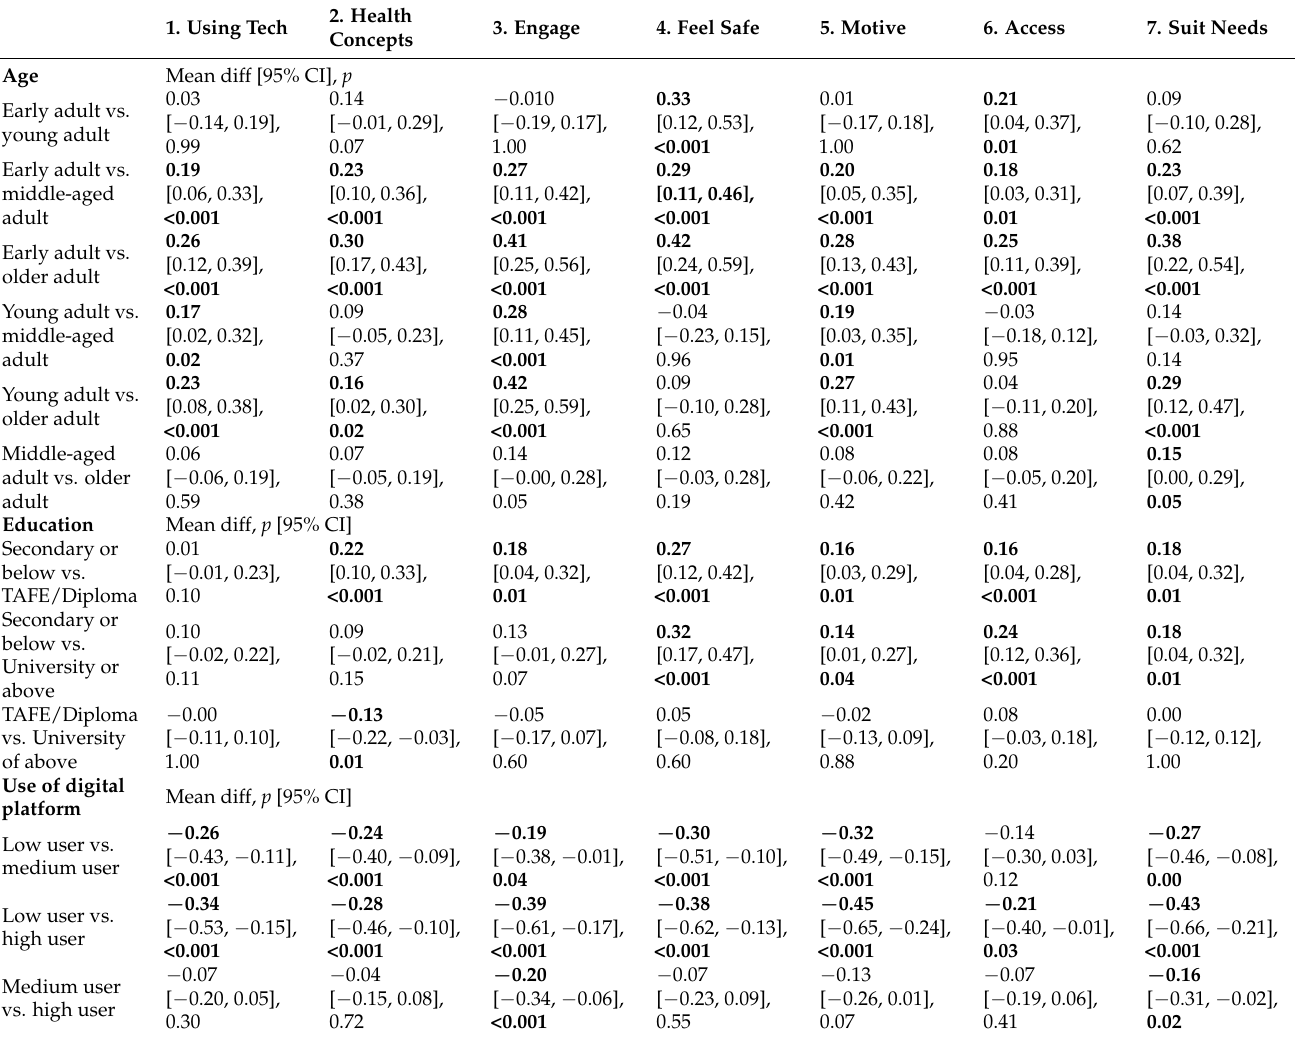
Table A2. Pairwise comparison tests among groups for age, education and use of digital platform and individual eHealth Literacy Questionnaire (eHLQ)